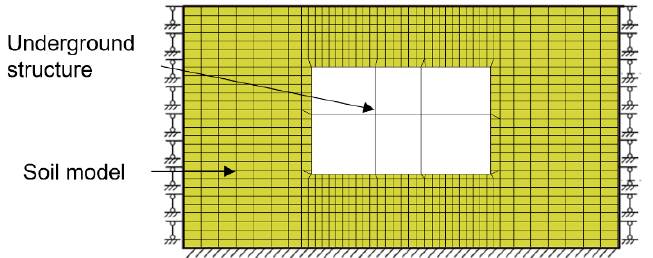
Figure 7. The FE model of the soil–underground structure.